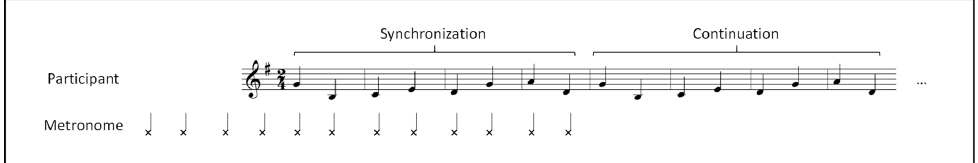
Figure 2. Synchronization-continuation trial. Participants synchronized the first iteration of each melody with a metronome (‘Synchronization’), and then performed two and a half additional melody iterations without the metronome (‘Continuation’). Four initial metronome beats set the performance tempo. The metronome sounded every 500 ms.